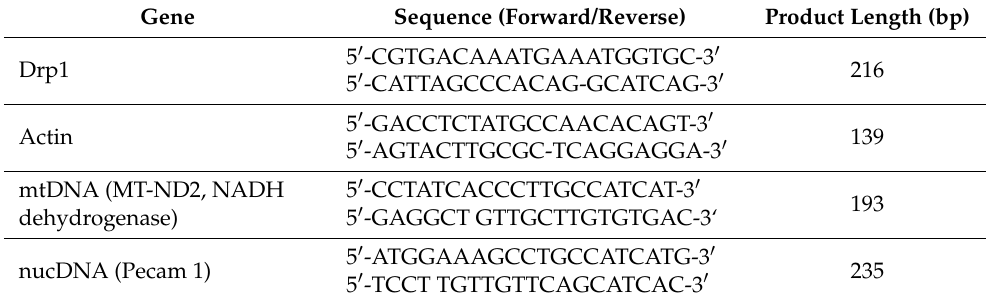
Table 2. Primers for